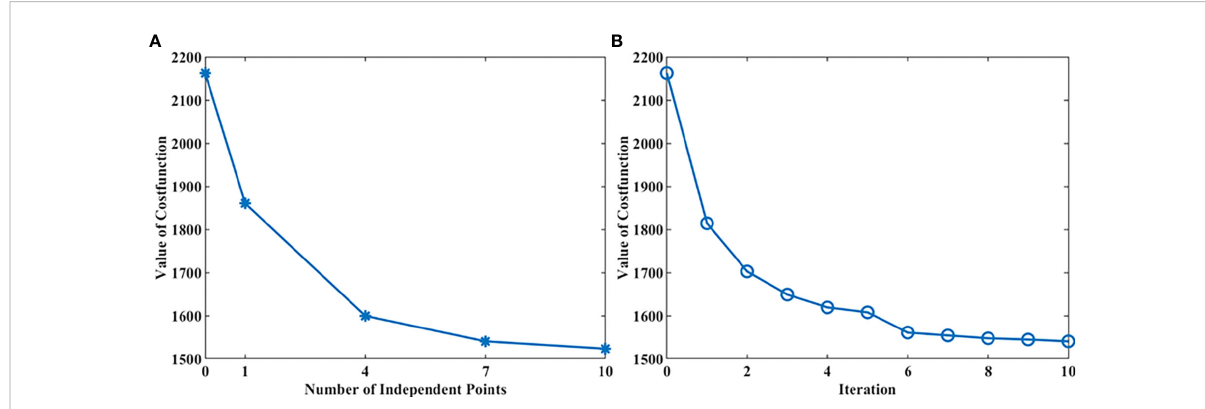
the NAO dataset (Figure 6B) are shown, respectively. Compared to them, it is clear that three amphidromic points in the simulated area and the results we obtained are consistent with those from other studies.